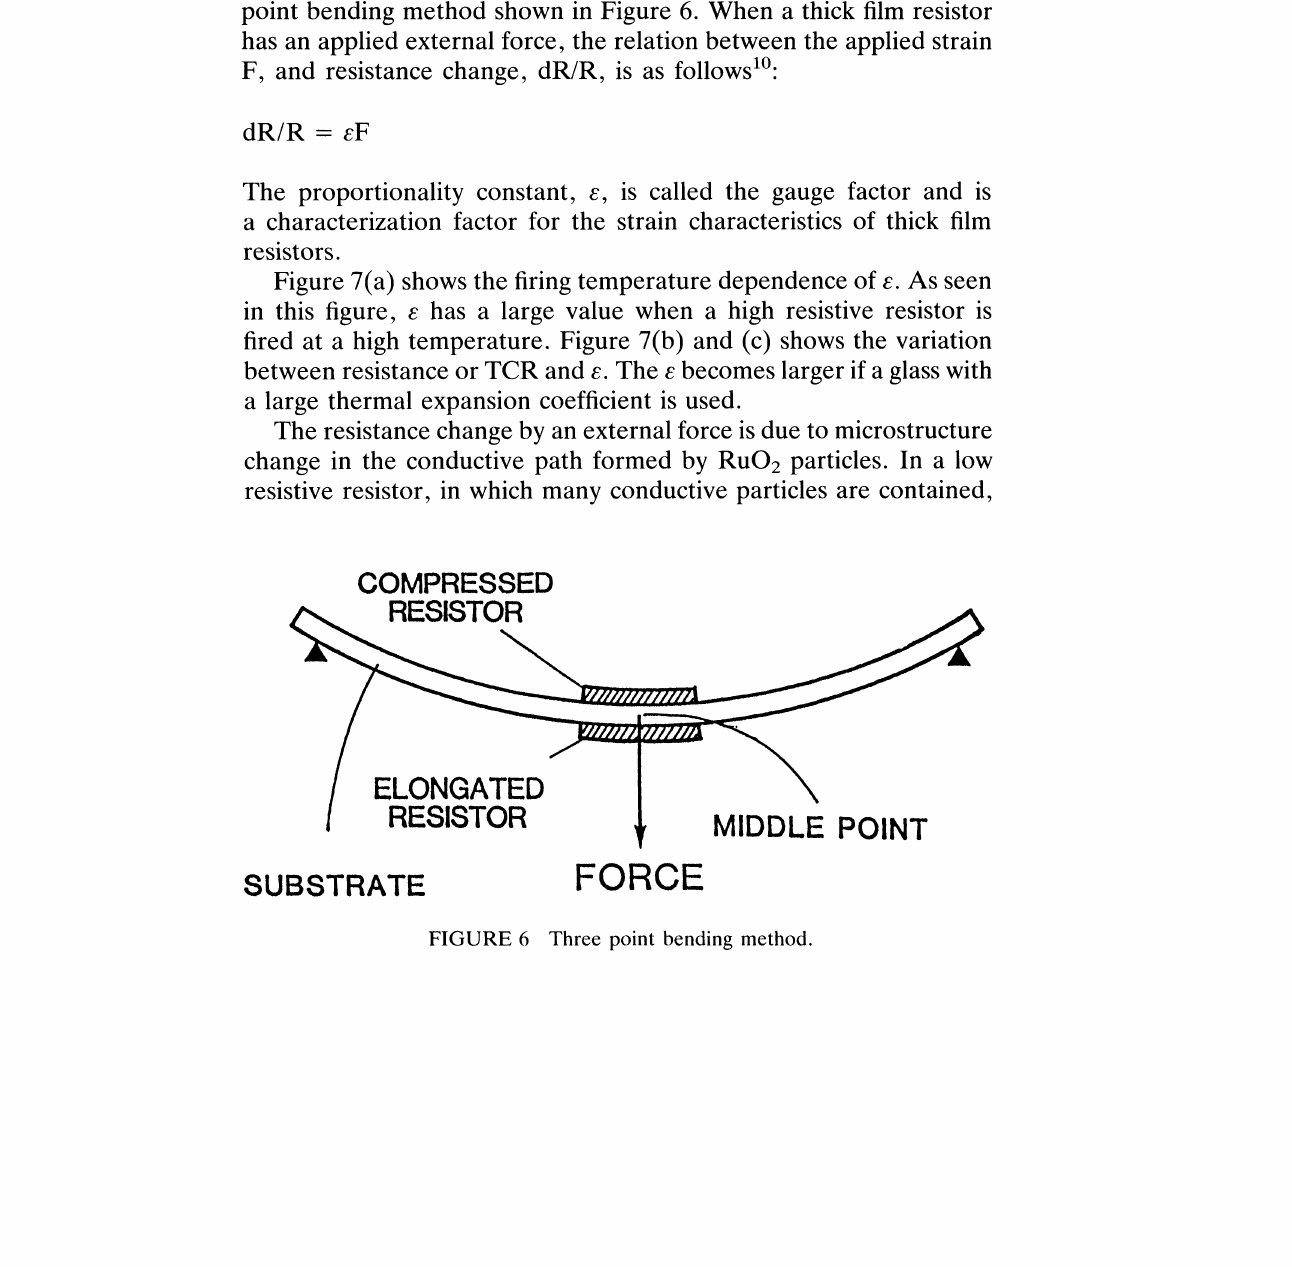
FIGURE 6 Three point bending